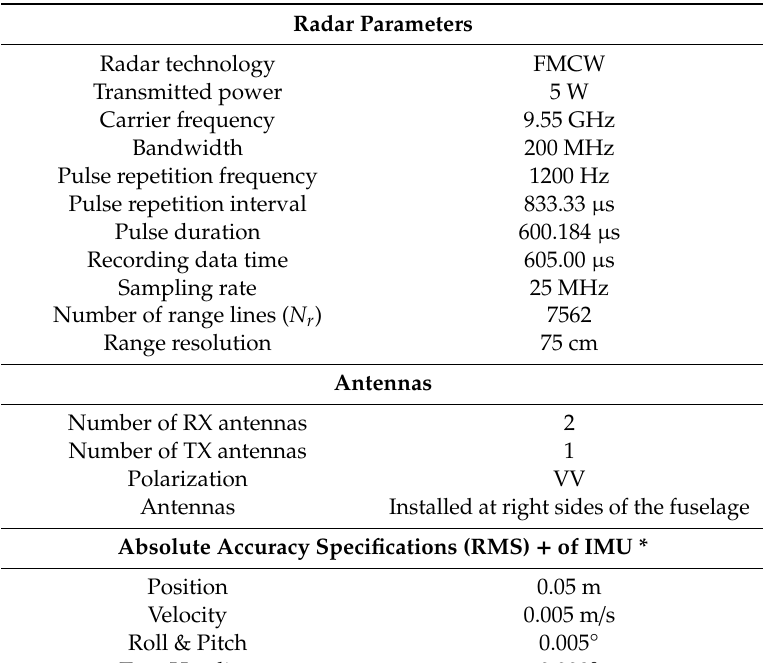
Table 1. AXIS system parameters.